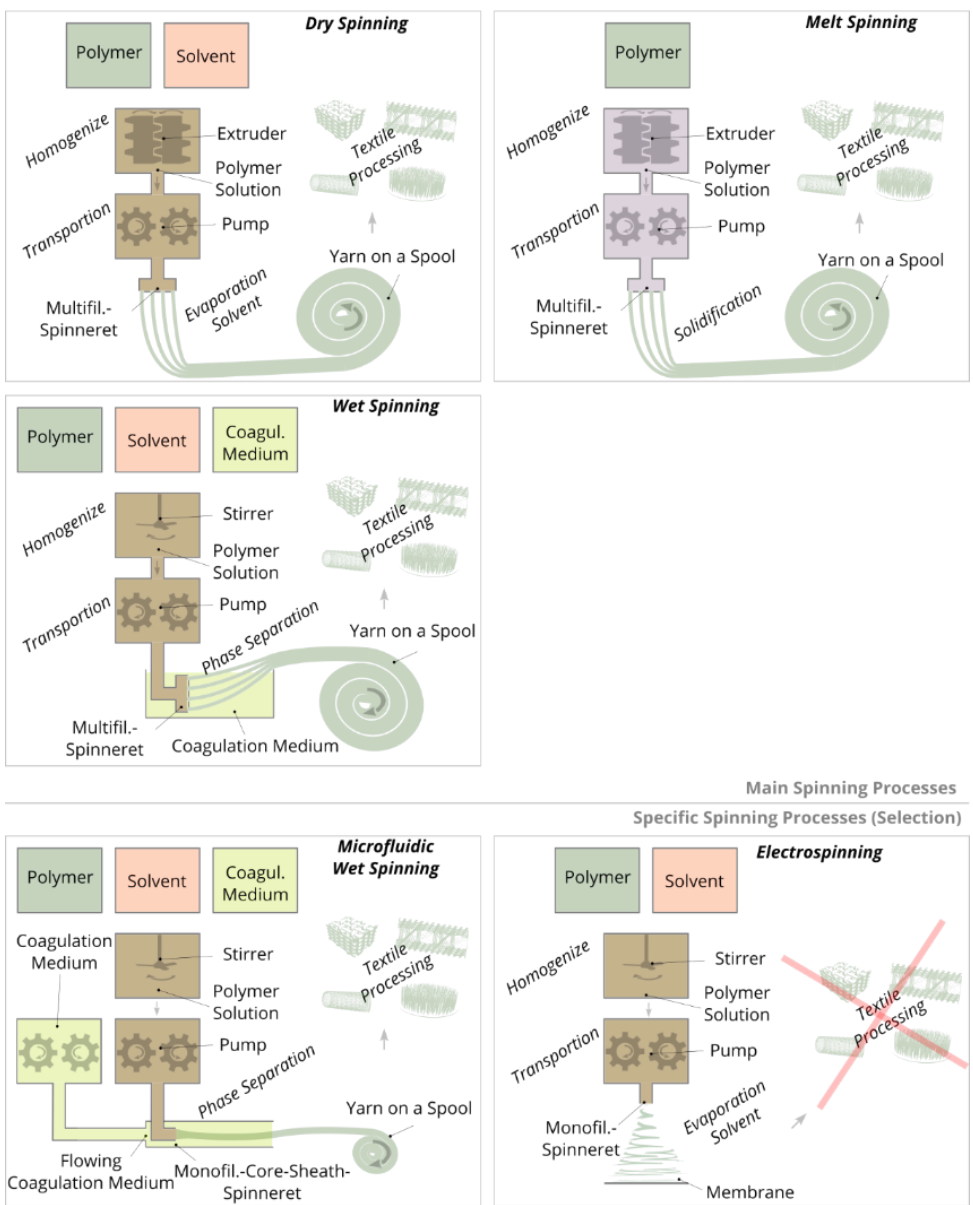
Figure 5. Schematic representation of the three main types of spinning processes: melt, dry and wet spinning for the production of filament yarns; electrospinning and microfluidic wet spinning are additionally shown. In all the processes illustrated, with the exception of electrospinning, yarn spools are produced which can be used for further textile processing. In the electrospinning process membranes or nonwovens are produced.